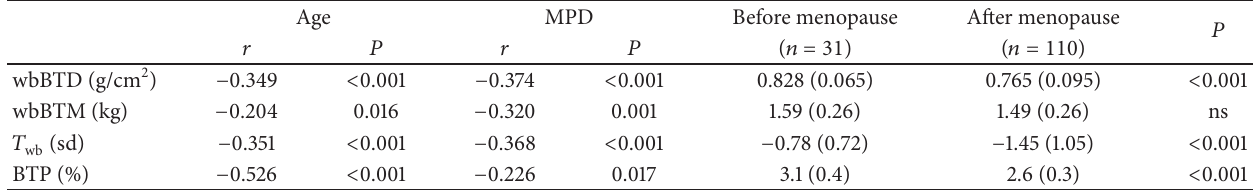
Table 3: Whole body bone tissue according to age and menopause ( 𝑛 = 141 ).